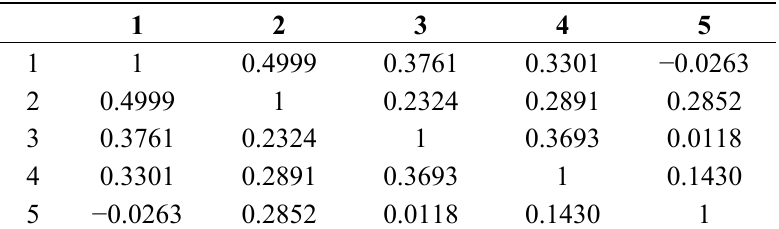
Table 5. Correlations between factor scores.